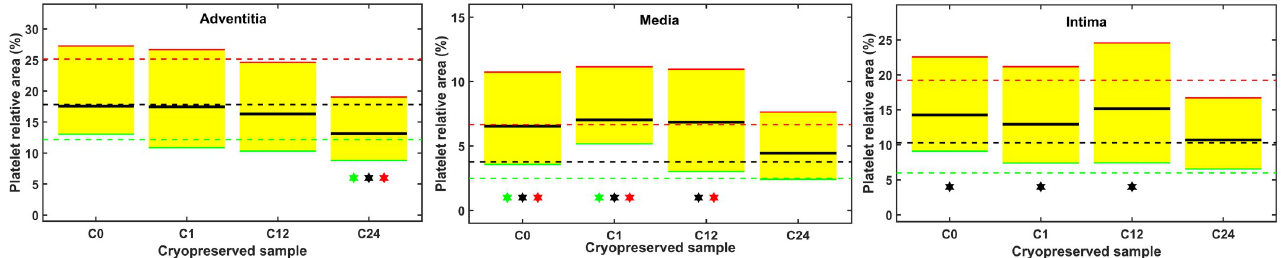
Fig 7. Qualitative quartile-wise comparison of the platelet adhesion on cryopreserved and native arterial allografts. Platelet coverage of the separate arterial wall layers was measured as illustrated in Fig 3. Lower (green), median (black) and upper (red) quartiles of the measured coverage data are shown with dashed lines for the BC and continuous lines for the cryopreserved samples. The interquartile range of the cryopreserved samples is shadowed in yellow. Symbols indicate significant differences between the respective BC and cryopreservation quartiles according to the cluster statistical approach described in Materials and